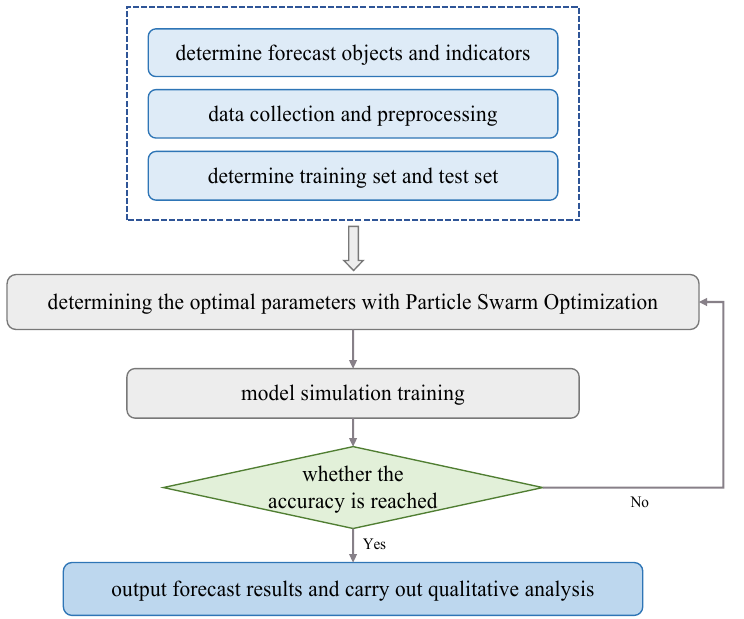
Figure 7. PSO-SVM model.